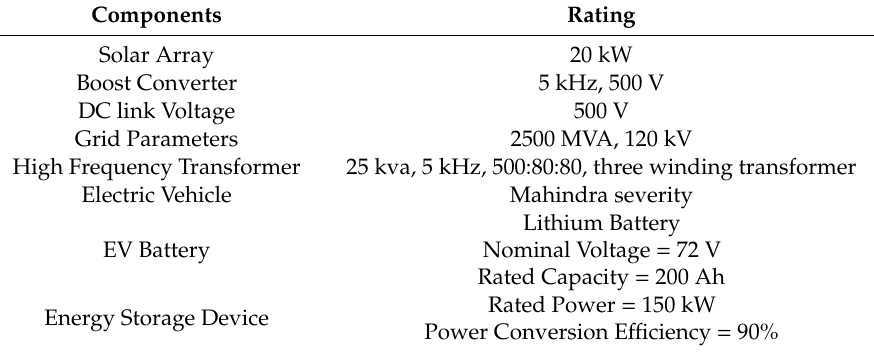
Table 1. Simulation parameters of grid-connected PV − EV charging station with an energy storage unit.